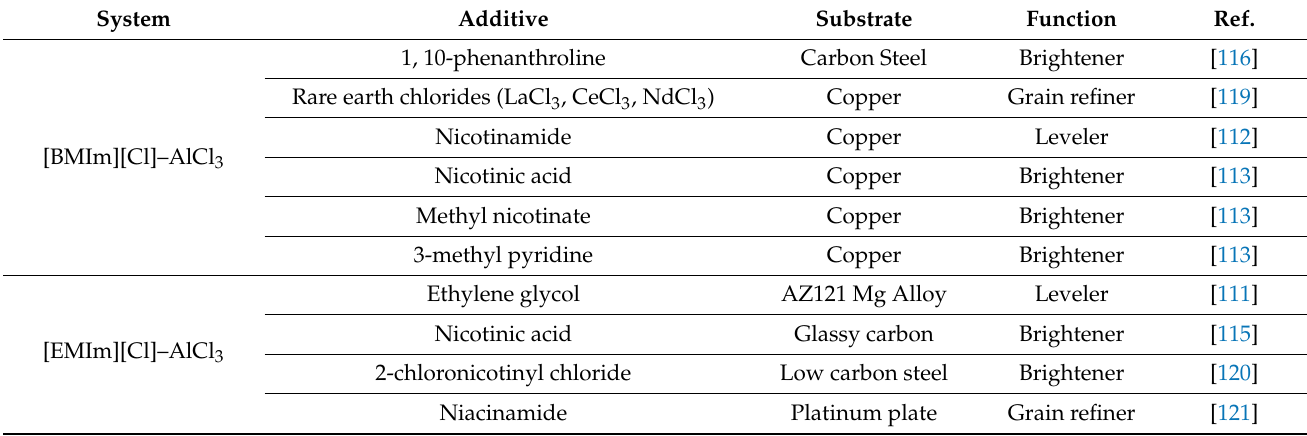
Table 8. Table showing the list of additives employed for the deposition of Al and Al alloys in various ILs. System Additive Substrate Function